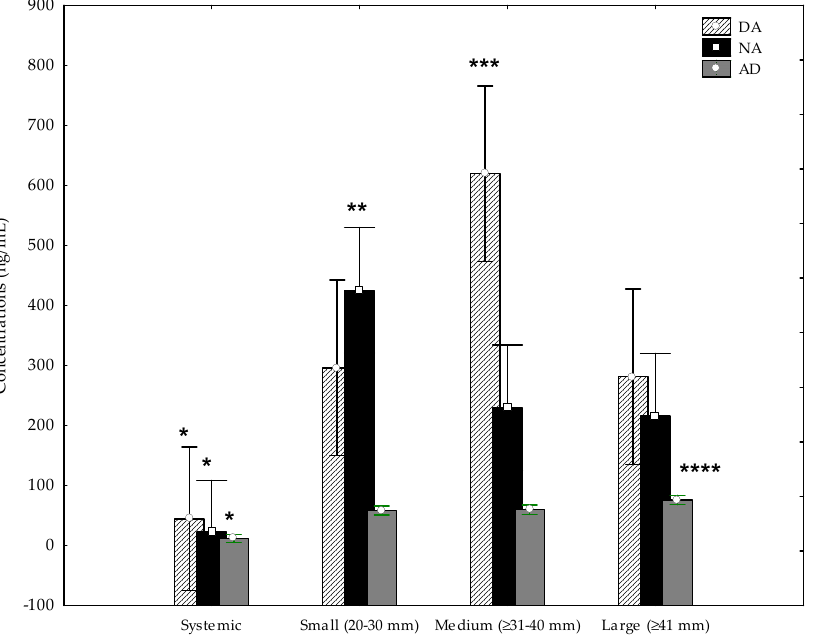
Figure 1. Concentrations of dopamine (DA), noradrenaline (NA) and adrenaline (AD) in systemic and follicular fluid (FF) of di ff erent follicles of mares (mean ± SD). Systemic fluid vs. small, medium and large follicles: * p < 0.05. Small vs. medium and large follicles: ** p < 0.05; medium vs. small and large: *** p < 0.05; large vs. small and medium **** p < 0.05. Intrafollicular noradrenaline (NA) concentrations were higher in small (472.2 ± 227.7 ng / mL), medium (244.7 ± 93.9 ng / mL) and large (210.1 ± 81.6 ng / mL) follicles than systemic fluid (17.12 ± 2.35 ng / ( p < 0.05; Figure 1).